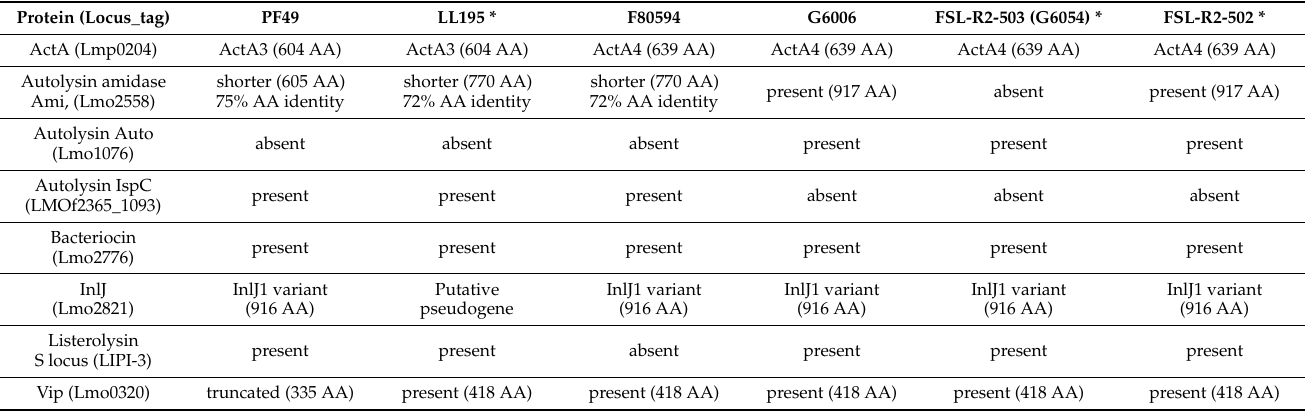
Table 3. Virulence-related genomic features of L. monocytogenes outbreak strains PF49, F80594 and G6006 included in this study. Other sequenced outbreak related strains (for the Swiss outbreak: LL195; the US outbreak: FSL-R2_503, FSL-R2-502) were analysed in addition. Amino acid (AA) identities are only shown when lower than 90%.